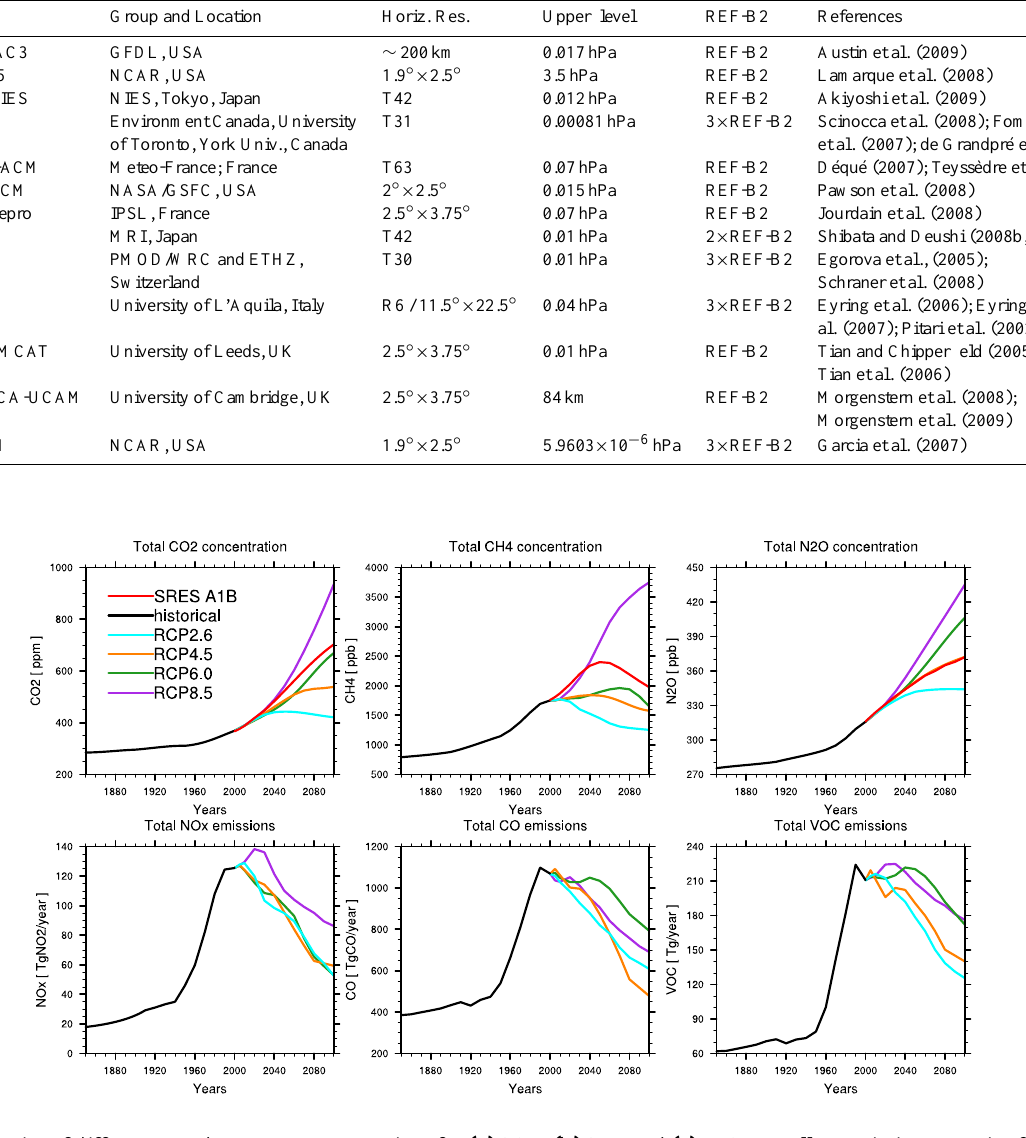
Fig. 1. Time series of different greenhouse gas concentrations for (a) CO 2 , (b) CH 4 and (c) N 2 O as well as emission scenarios for (d) NO x , (e) CO and (f) VOC in the historical period (1850 to 2000) and for the four RCPs (2000 to 2100). Additionally, the GHG scenarios are shown for the SRES A1B